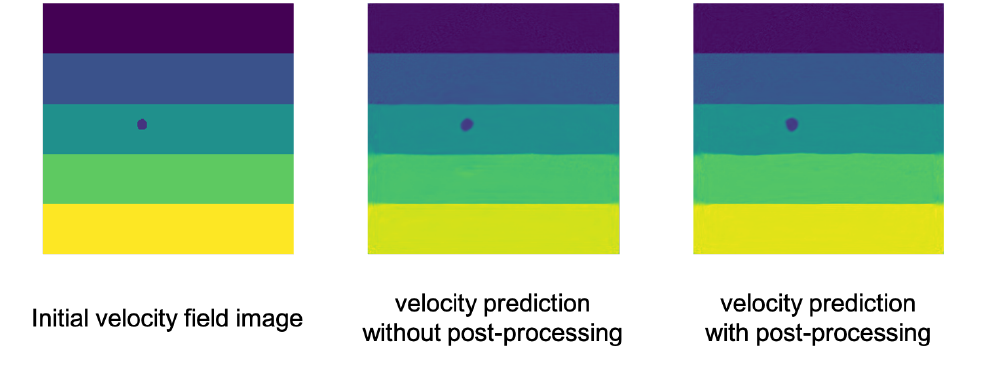
Figure 6. Post-processing step.